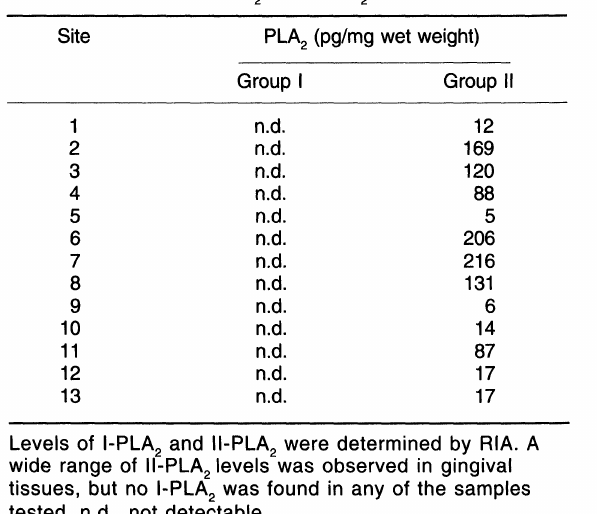
Table 1. The levels of I-PLA and II-PLA